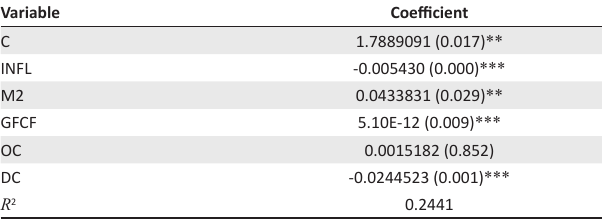
TABLE 4: Estimation of the model with random